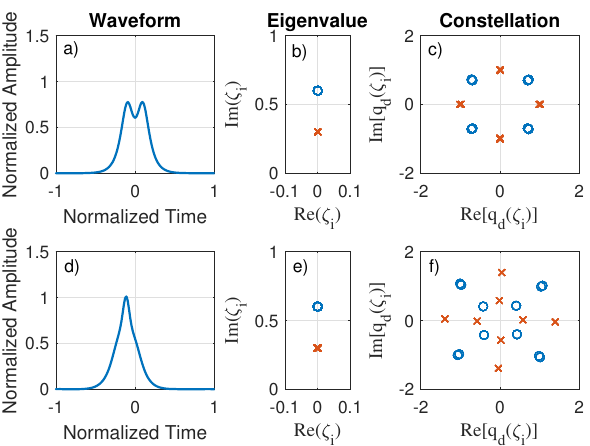
Figure 10. Simulation results with a symbol period equal to T S1 at 1600 km of propagation distance. The system includes only the third-order dispersion. ( a – c ) Results a with launch power of 1 dBm. ( d – f ) Results with a launch power of 12 dBm. ( a , d ) Received waveform of one symbol of the sequence. ( b , e ) Received eigenvalues. ( c , f ) Normalized received spectral function constellations, q d ( ζ 1 ) (blue circles) and q d ( ζ 2 ) (red